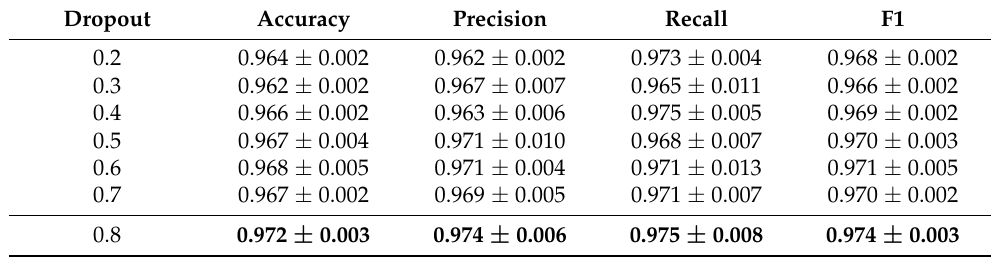
Table 5. MCNN-IFGS performance comparison of different dropout values on the Chinese review dataset. The value before “ ± ” was the mean value, followed by the standard